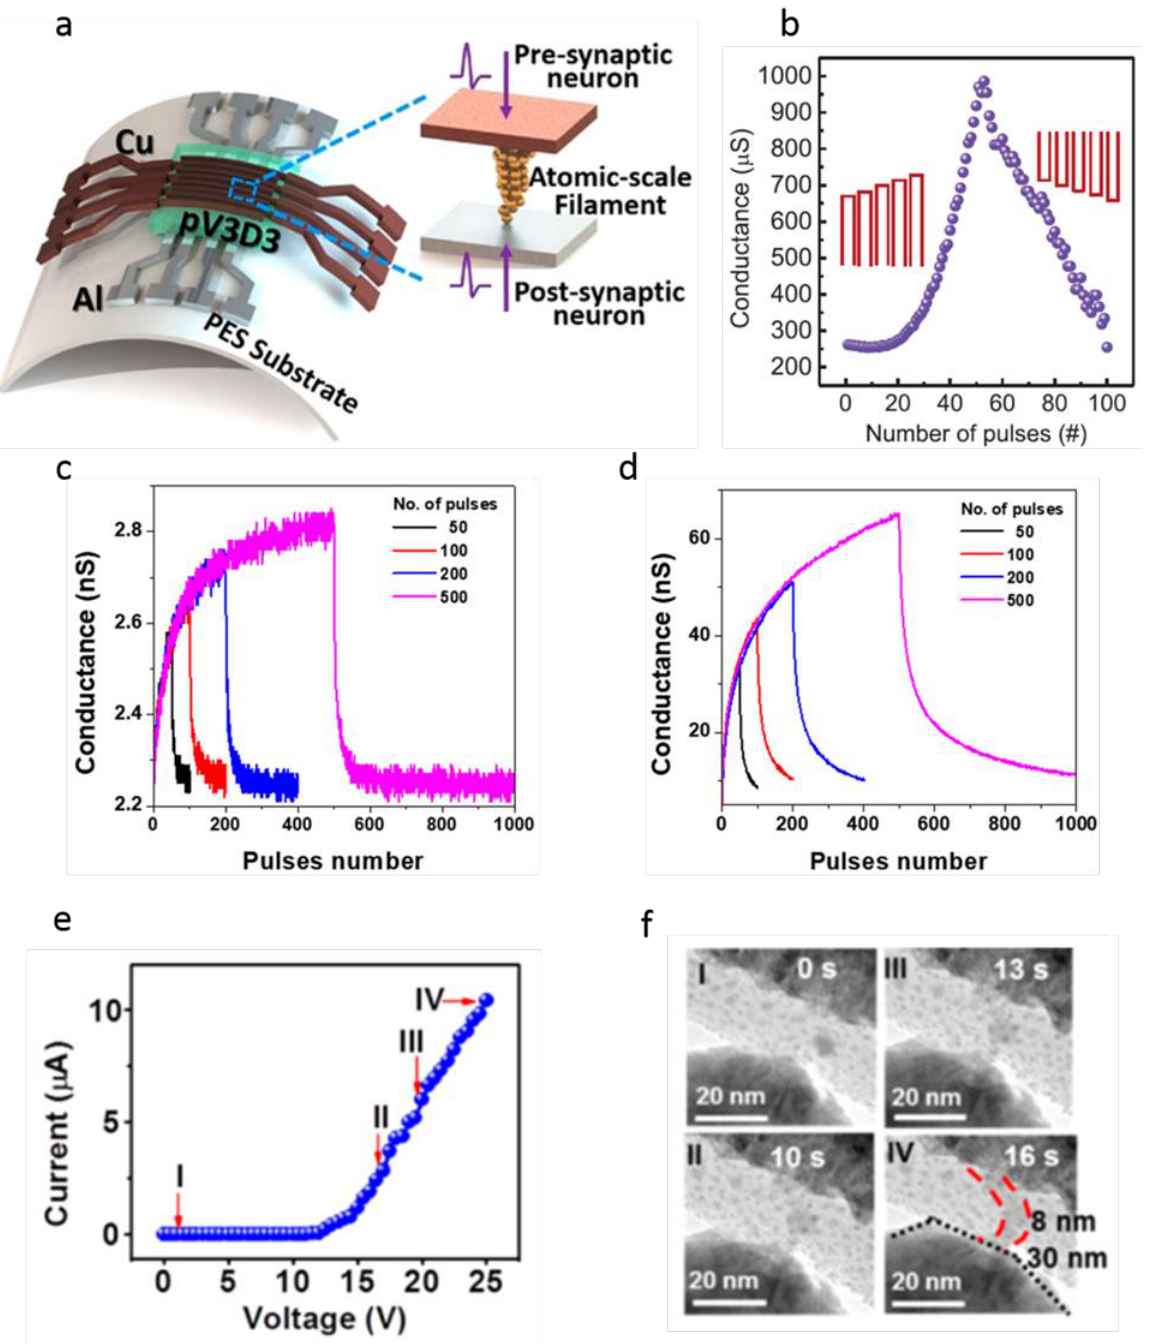
Figure 5. ( a ) Schematic image of pV3D3-based flexible synaptic device using the formation and rup- ture of Cu ion-movement-based filament. ( b ) Potentiation (depression) curve obtained by smart pulse scheme with increasing amplitude in the range of 2~4 V ( − 1.2~ − 1.4 V) with a width of 60 ns (100 ns) for a pV3D3-based flexible synaptic device. Reprinted/adapted with permission from Ref. [34]. 2018, American Chemical Society. ( c , d ) A comparison of potentiation – depression curves of the Ag/SiN x /a-Si/p ++ Si-based devices with unimplanted ( c ) and implanted ( d ) devices under varying numbers of stimulation pulses of 7.0 ( − 3.0) V for potentiation (depression). Reprinted/adapted with permission from Ref. [36]. 2020, Springer Nature. ( e ) Gradual current change and ( f ) simultaneously obtained transmission electron microscope image of a Cu tip/SiO 2 /W cell during injection of voltage with increased amplitude. Reprinted/adapted with permission from Reference [86]. 2017, American Chemical Society.